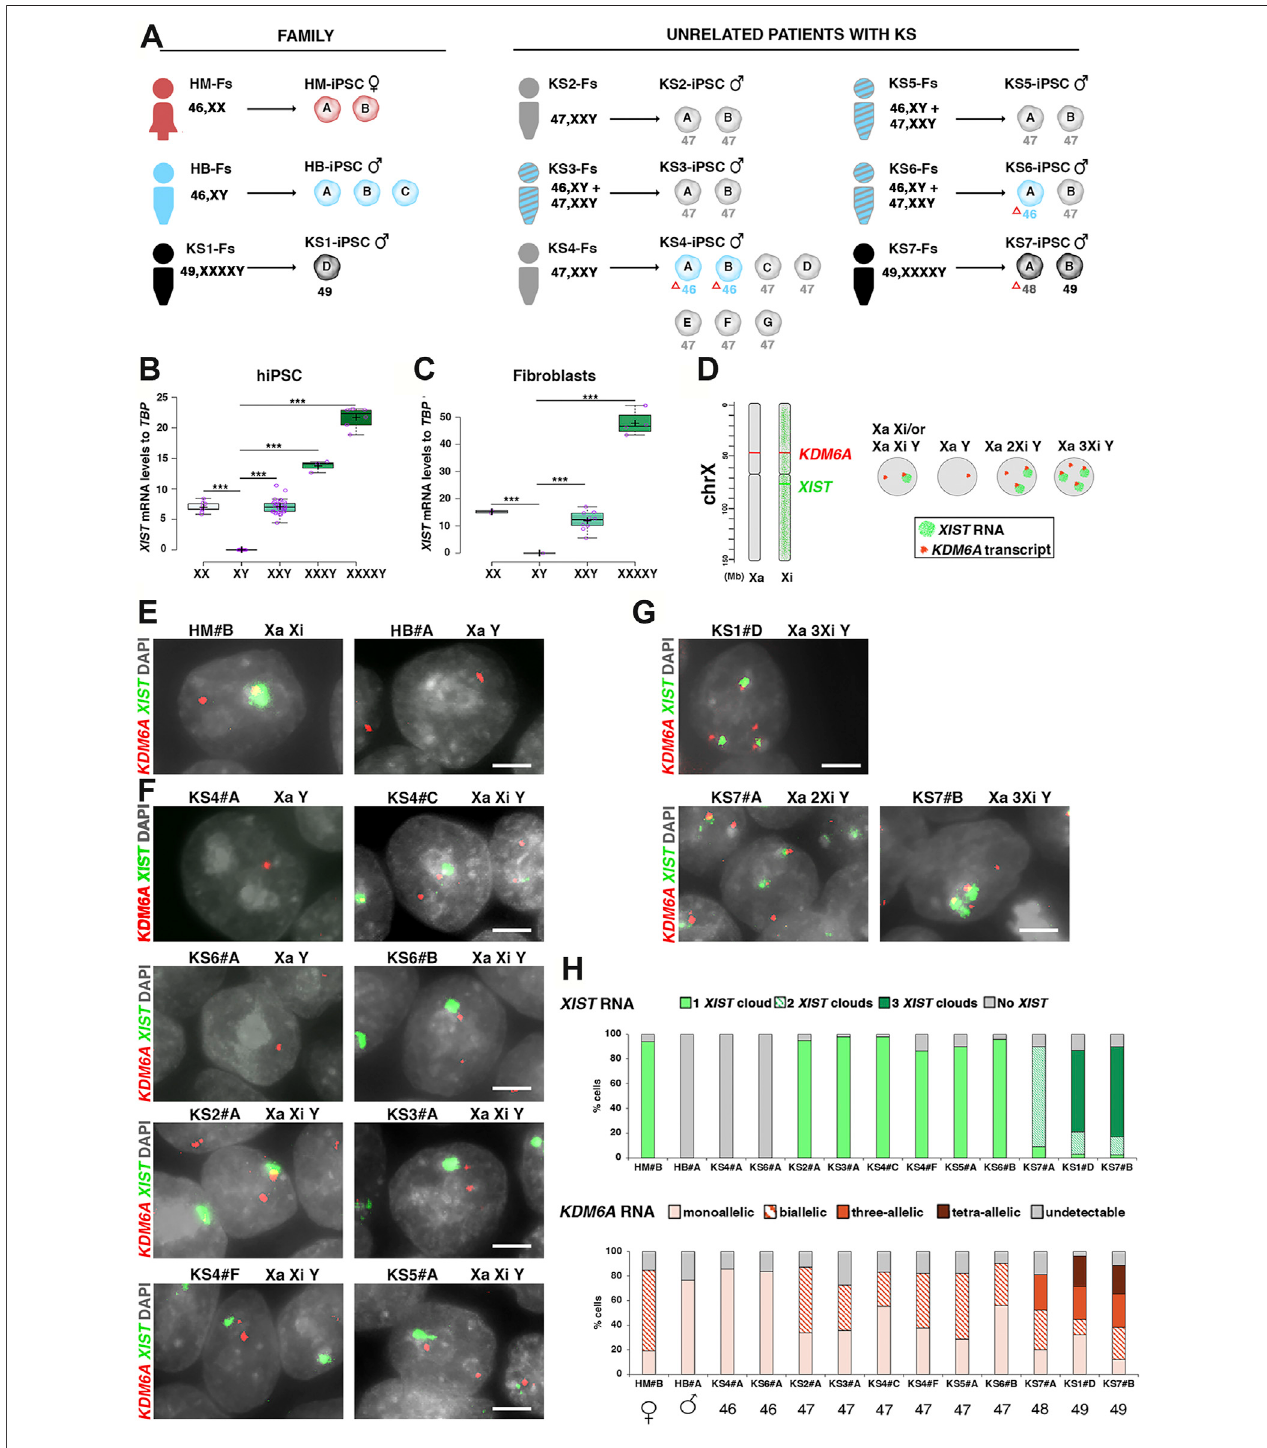
FIGURE1| Patientcohortdescription andXISTdosagevalidation. (A) CohortofrecruitedpatientswithKSandHGA,including fi broblastsand independent hiPSC clones derived from each patient and healthy controls. Each karyotype is speci fi ed by color: red, healthy mother; blue, healthy brother and isogenic 46,XY; black, 49,XXXXY and 48,XXXY; gray, non-mosaic 47,XXY; blue with gray stripes, mosaic 47/46,KS. The red triangle ( Δ ) indicates spontaneous X chromosome loss during reprogramming or naturally isogenic lines. (B) Box plot showing XIST expression in hiPSCs (C) and fi broblasts for the indicated karyotypes measured by Taqman quantitative polymerase chain reaction (q-PCR). Each purple dot represents a q-PCR expression analysis from at least three (hiPSCs) and two ( fi broblasts) independent experiments.Eachbiologicalreplicateisde fi nedasanindependentRNAsampleobtainedatconsecutivepassagesfromthesameiPSCcloneorfromindependentiPSC